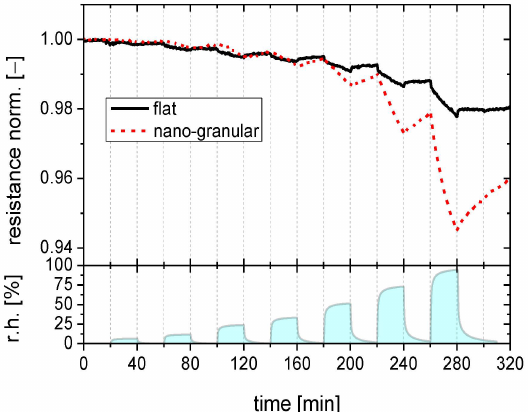
Figure 2. Gas response of SnO layers with a flat (full line) and a nano-granular (broken 2 line) surface morphology towards water vapor when stored close to room